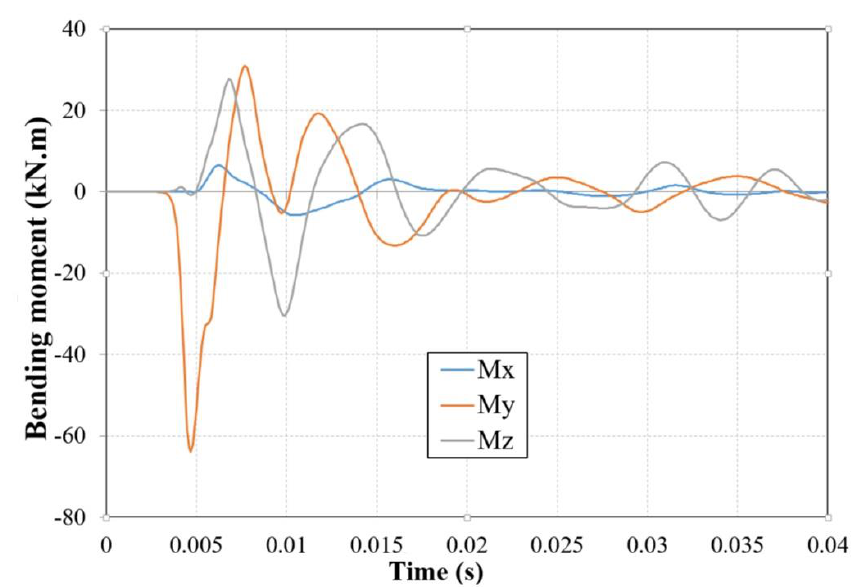
Figure 8. Components of bending moment acting on the obstacle at a distance of 2.5 m depending on time.